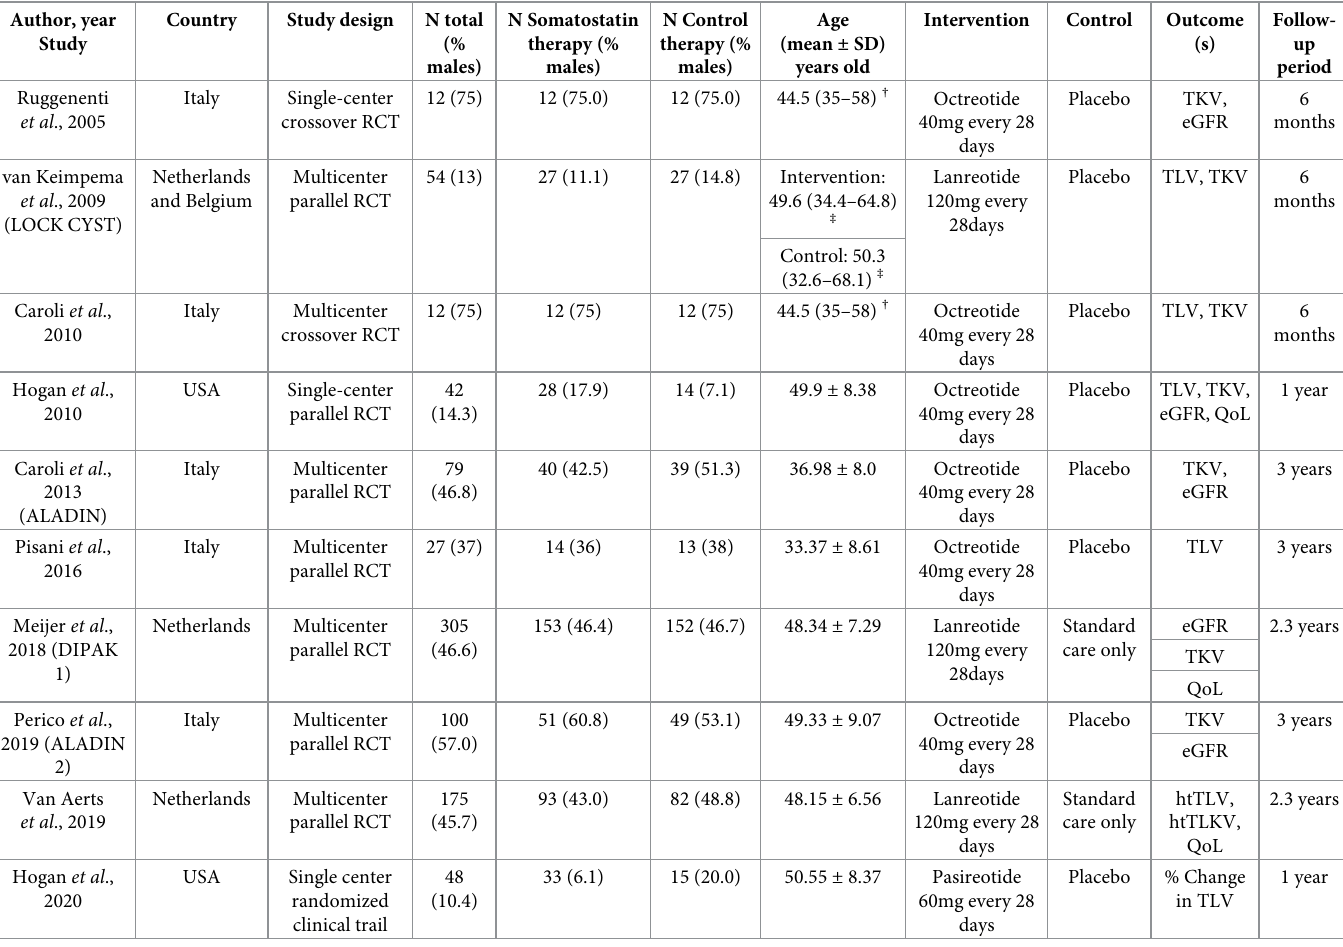
Table 1. Characteristics of the included